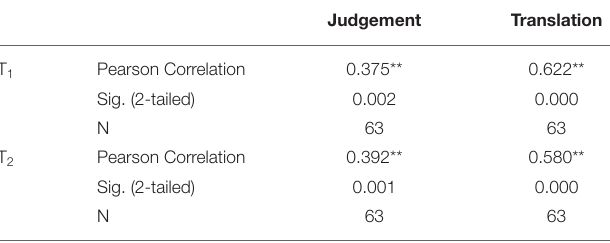
TABLE 8 | The correlations between emotional valence and translation and judgment